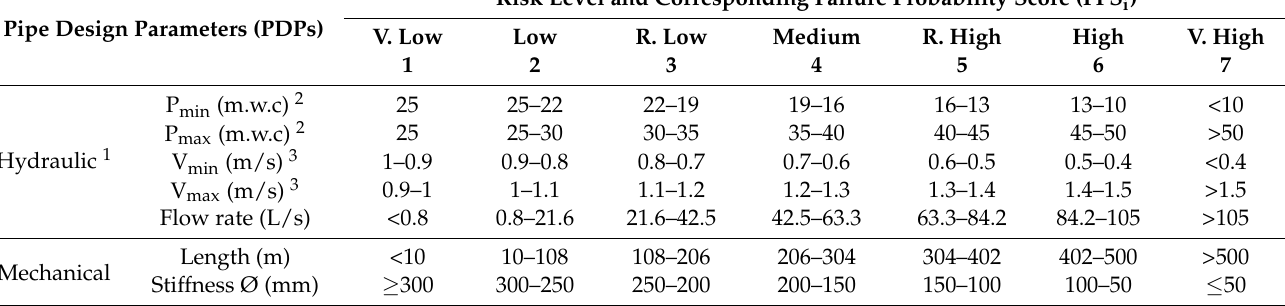
Table 2. Risk level and corresponding failure probability